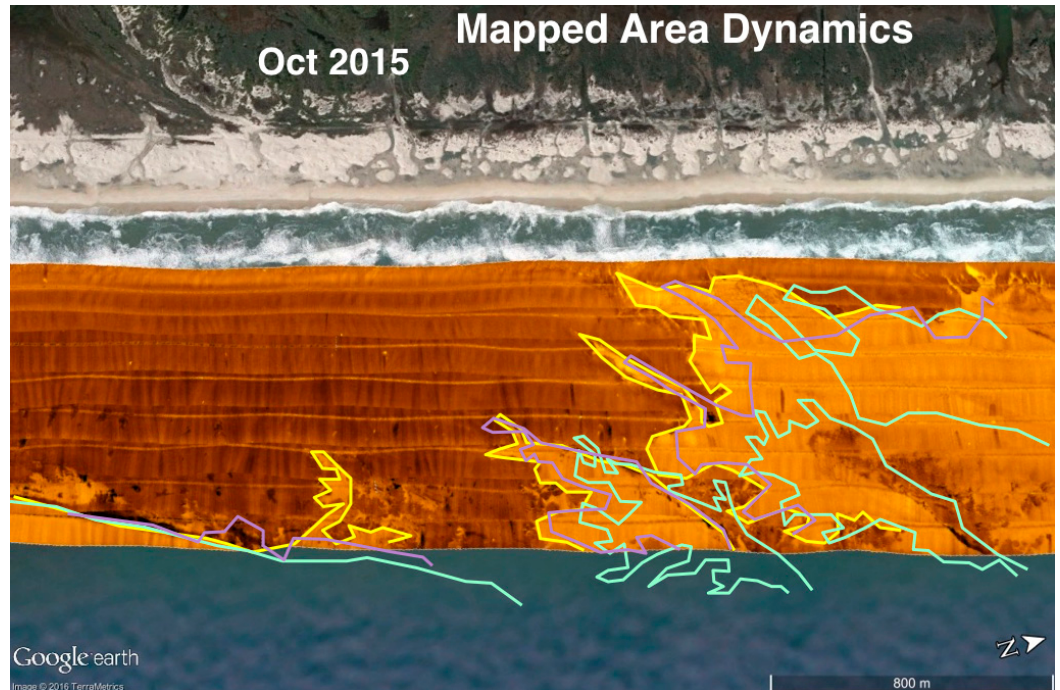
Figure 12. October 2015 side-scan mosaic and sediment classification shapefile compared to May 2015 (Figure 11) and 2011 (Figure 10).